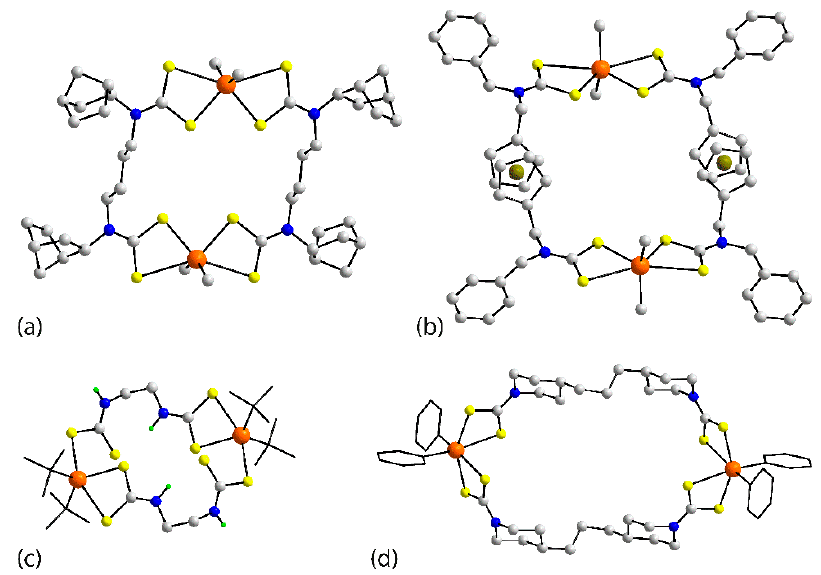
Figure 15. Molecular structures of ( a ) (Me 2 Sn) 2 (L 24 ) 2 in the crystal of 54 , ( b ) (Me 2 Sn) 2 (L 26 ) 2 in 56 , ( c ) [(tBu) 2 Sn] 2 (L 18 ) 2 in 63 , and ( d ) (Ph 2 Sn) 2 (L 32 ) 2 in 66 . [(tBu) 18 ) 2 Sn] 2 (L 2 in 63 , and ( d ) (Ph 2 Sn) 2 (L